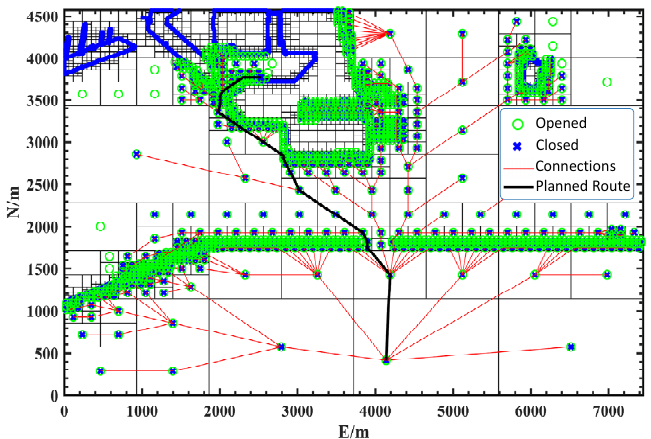
Figure 5. Path planned by multi-scale A* algorithm.